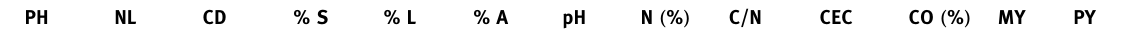
Table 7: Pearson ’ s correlation of soil properties and plant